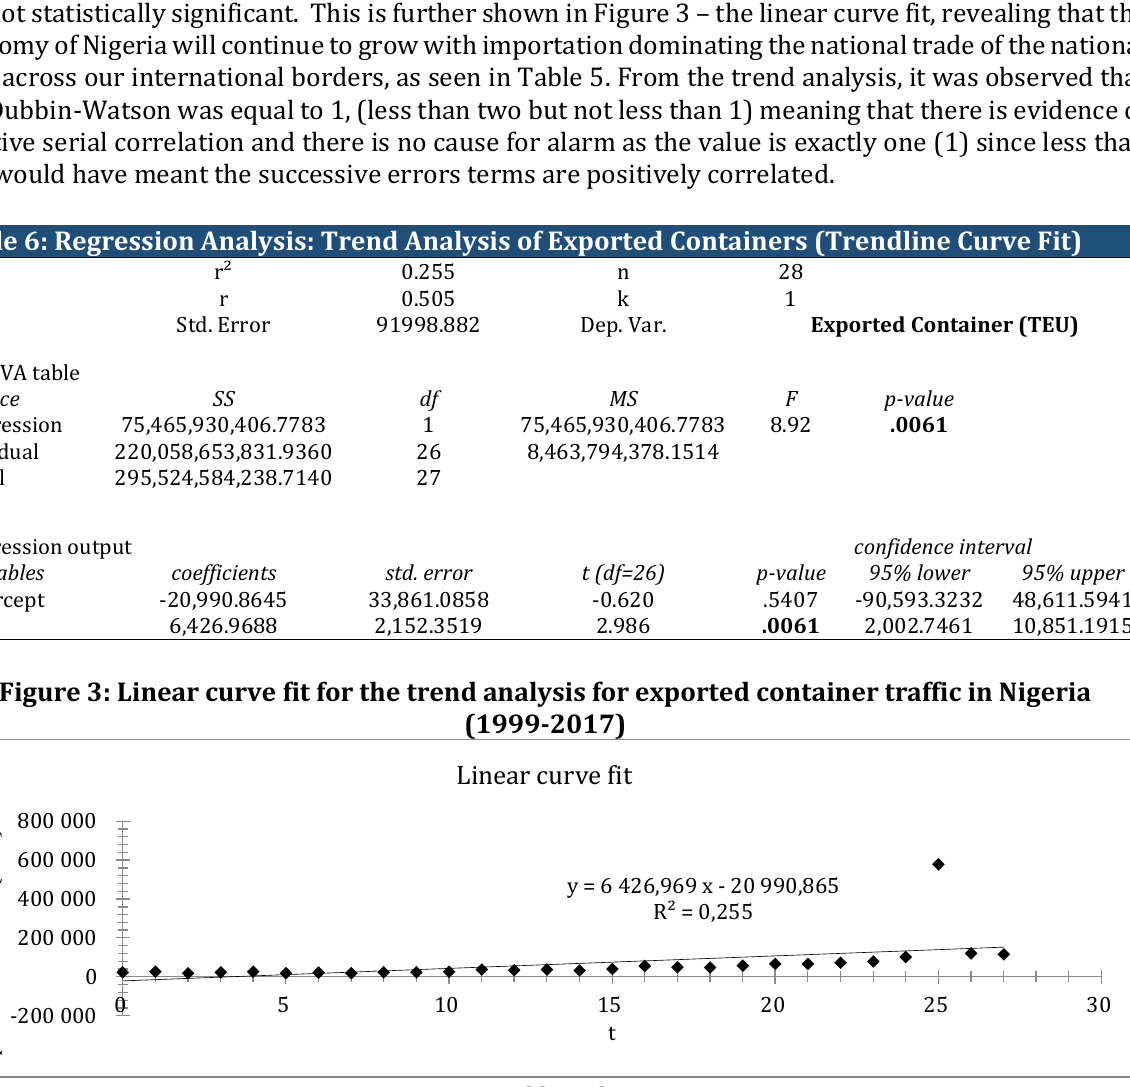
Table 7: Predicted values for Exported Container (TEU)